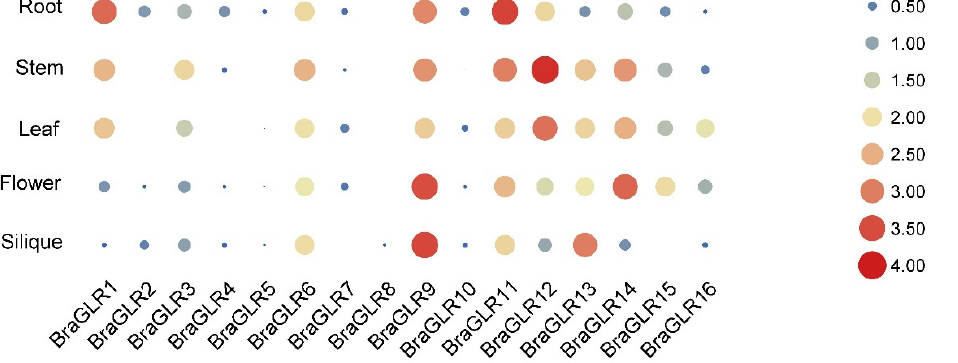
Figure 5. Transcript level analysis of GLR genes in different tissues of B. rapa . Larger area and darker color indicate higher expression. All values underwent logarithmic transformation.